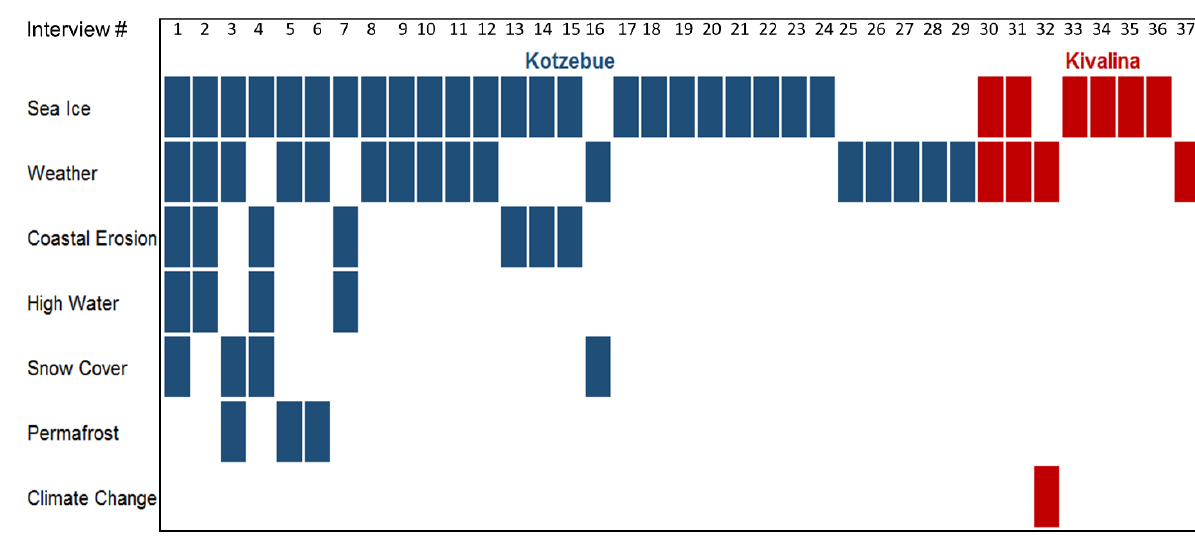
Figure A3.1 Climate stressors on y-axis (sea ice, weather, coastal erosion, high water, snow cover, permafrost and climate change) and interview respondents (x-axis) represented as blue rectangles (Kotzebue interviews) or red rectangles (Kivalina